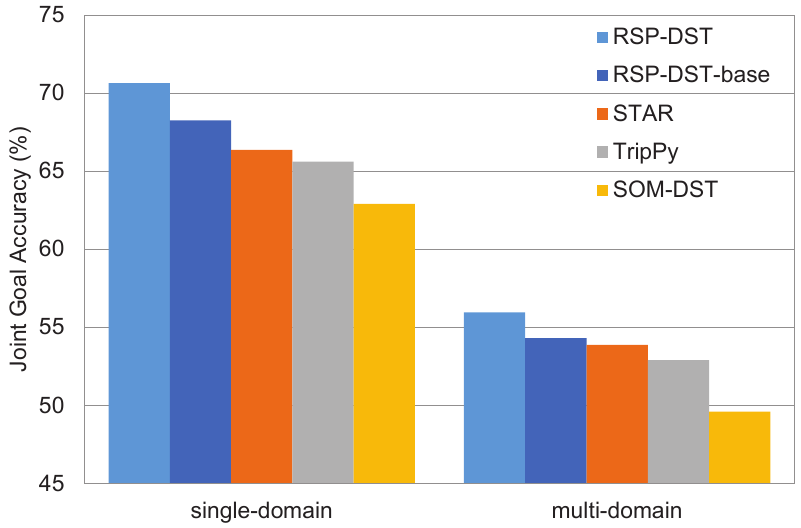
Figure 4. Joint goal accuracy of the single- and multi-domain on the test set of MultiWOZ 2.1.